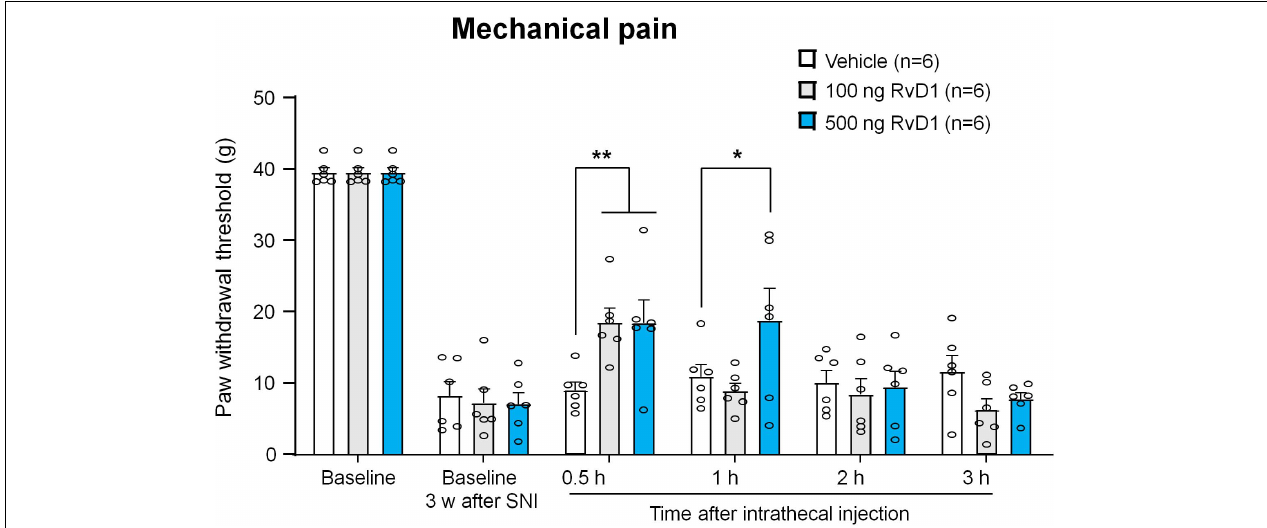
FIGURE 5 | Intrathecal RvD1 reduces SNI-induced mechanical allodynia in rats. RvD1 (100 and 500 ng) was intrathecally injected 3 weeks after SNI. Note that RvD1 produces a dose-dependent inhibition of neuropathic pain. * p < 0.05, ** p < 0.01 versus vehicle group. Two-Way ANOVA with Bonferroni’s post hoc test, n = 6 rats per